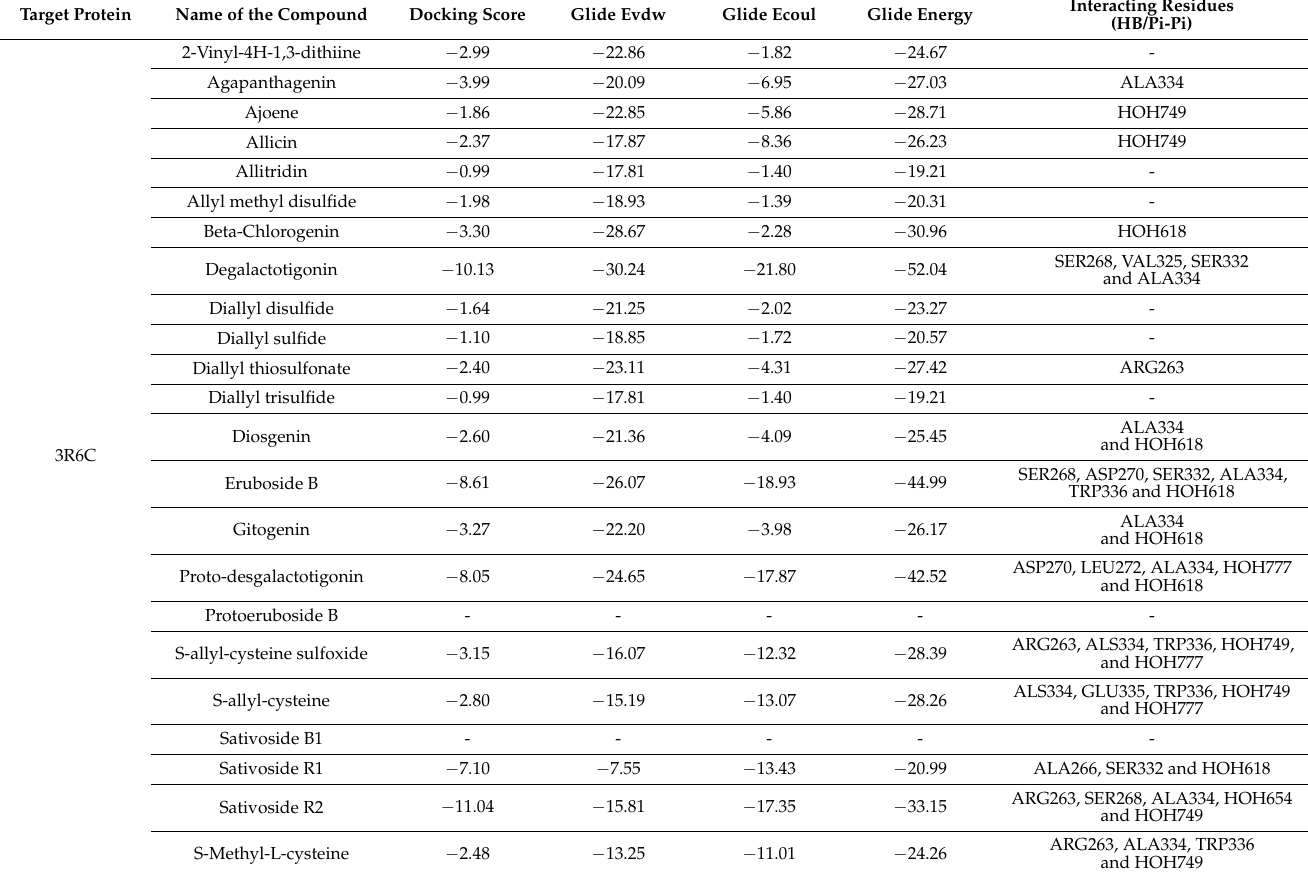
Table 3. The docking score, Glide evdw (Van Der Waals energy), ecoul (Coulomb energy), interacting residues and the type of interaction of 23 bioactive compounds with the protein anthranilate phos- phoribosyltransferase (trpD). The docking scores calculated using Glide program of Schrodinger Maestro (version